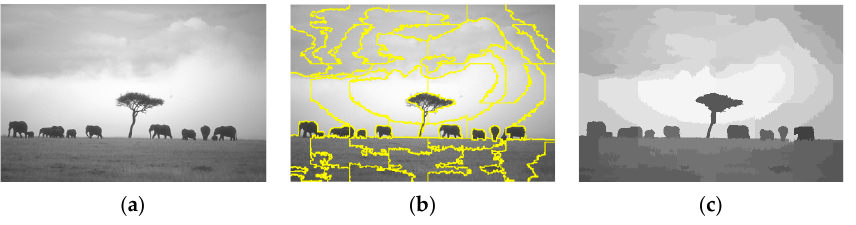
Figure 2. Super-pixel segmentation diagram of image #253036 from BSDS ( K = 30): ( a ) Original image, ( b ) Super-pixel boundary, ( c ) Super-pixel averaging image.